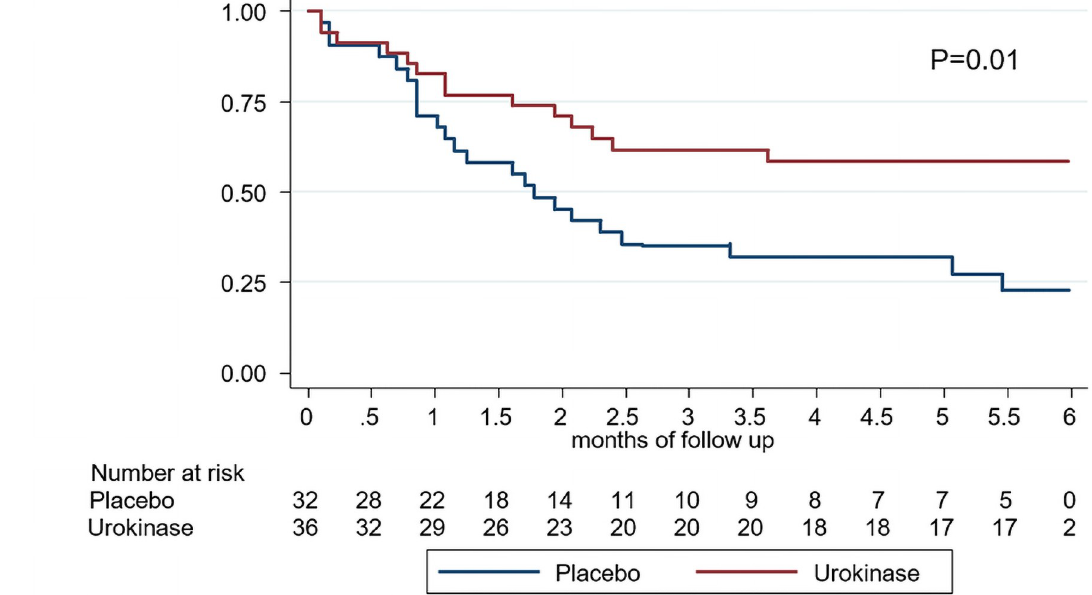
Fig 2. Proportion of catheters free of thrombotic dysfunction. Kaplan-Meier estimates with censoring at the time of the first thrombotic dysfunction. Population at risk during the 6 months follow up is indicated under the graph. Placebo (blue lines) and once weekly urokinase (red lines). P value of null hypothesis of no difference in survival by log-rank test = 0.01.